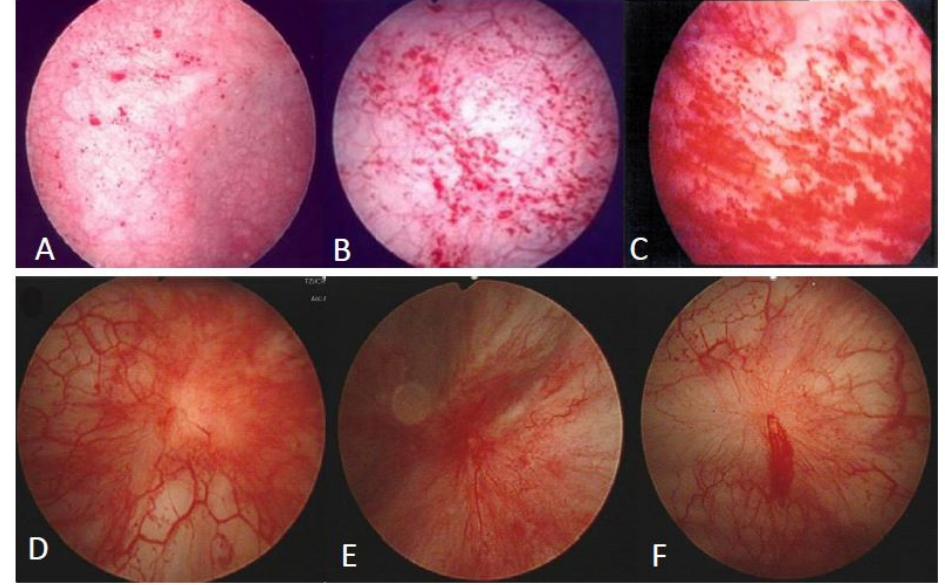
Figure 1. Findings of cystoscopic hydrodistention in patients with interstitial cystitis (IC) subtypes: ( A ) Non-Hunner’s IC (Non-HIC) with grade 0–1 glomerulation; ( B ) Non-HIC with grade 2 glomerulation; ( C ) Non-HIC with grade 3 glomerulation; ( D – F ) Hunner’s IC.